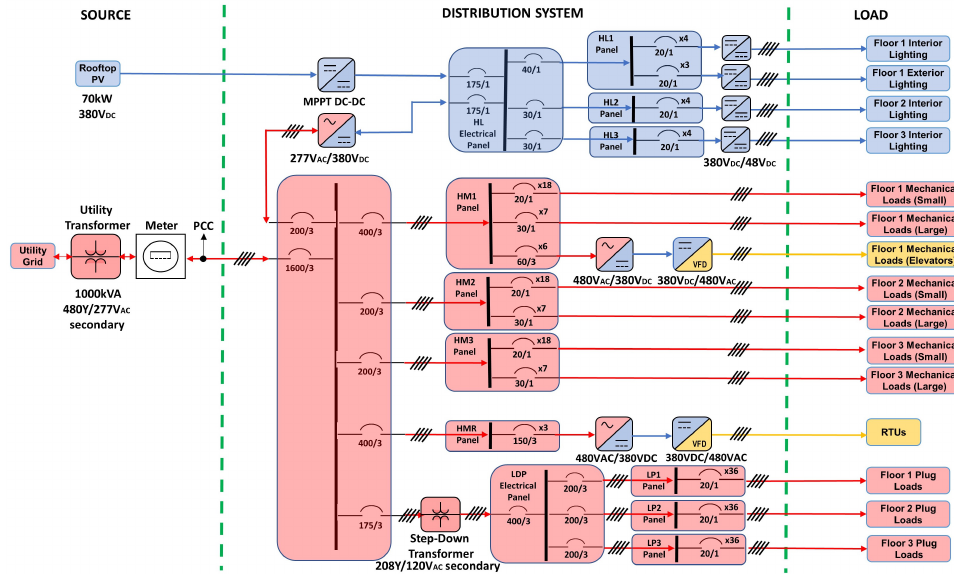
Figure 5. Modified hybrid AC/DC electrical distribution system